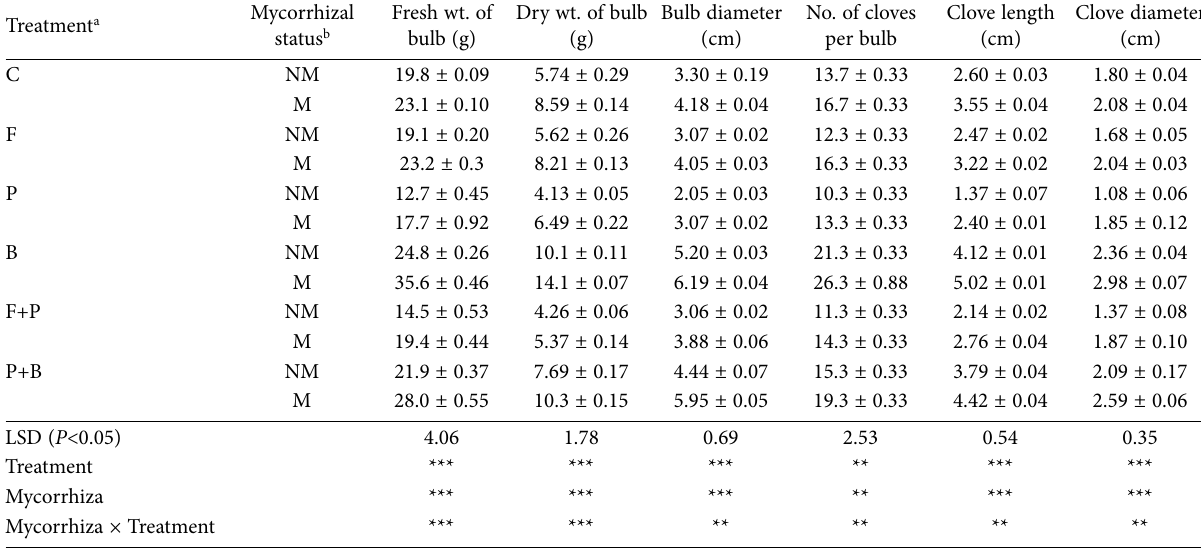
Table 3. Mean garlic plant yield parameters (± standard error) for plants treated with AMF and/or Bacillus amyloliquefaciens GGA as bio- control agents against Sclerotium cepivorum .